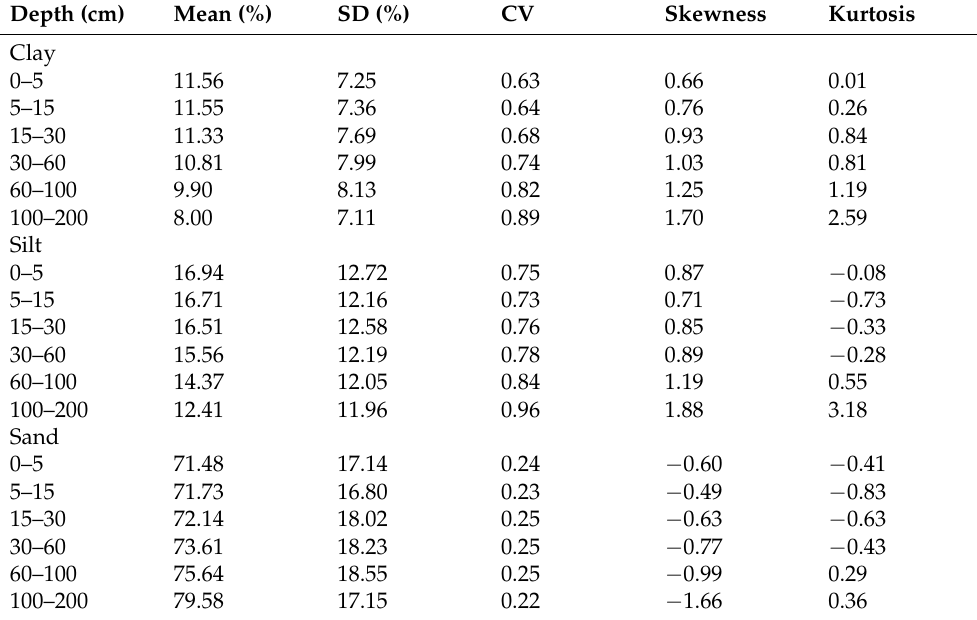
Table 2. Statistical analysis of the clay, silt and sand percentages at different depths.